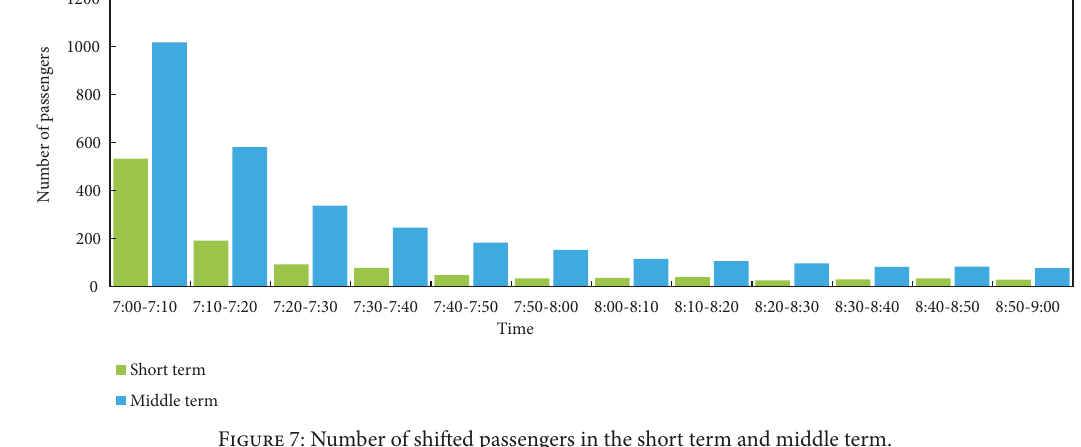
Figure 7: Number of shifted passengers in the short term and middle term.